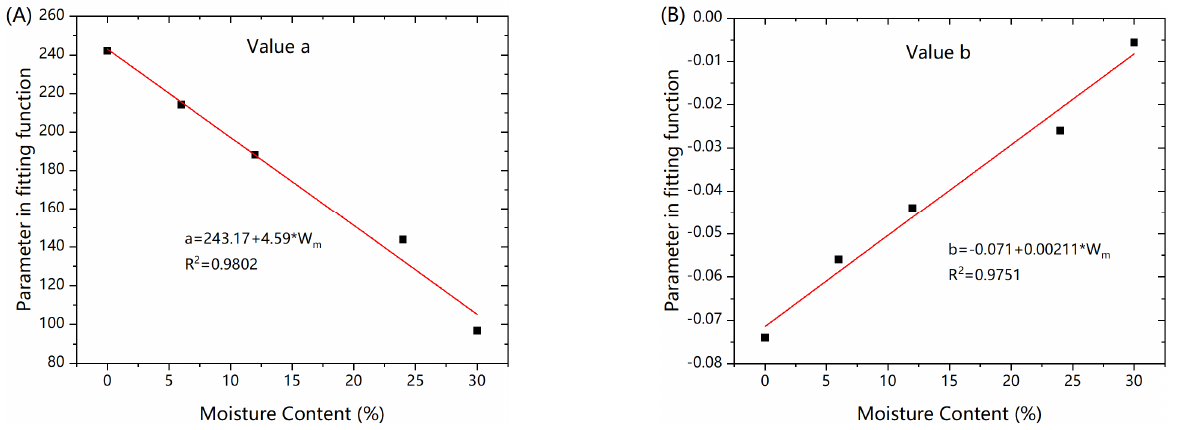
Figure 7. Value a and value b in fitting function. ( A ) comparison of a value under different humidity, ( B ) comparison of b value under different humidity.